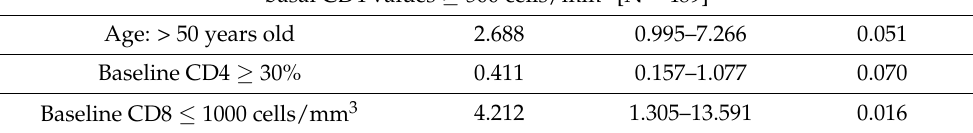
Table 2. Cont. Variable OR IC 95% p -Value Model 4. To achieve CD4/CD8 ≥ 0.9 at 24 weeks in PLWHIV to be treated DTG + 3TC and with basal CD4/CD8 < 0.9 [N = 272] NNRTI 2.119 0.906–4.955 0.083 Baseline CD4 ≥ 30% 0.336 0.111–1.019 0.054 Baseline CD8 ≤ 1000 cells/mm 3 0.326 0.129–0.823 0.018 Model 5. To achieve CD4 < 500 cells/mm 3 at 24 weeks in PLWHIV to be treated DTG + 3TC with basal CD4 values ≥ 500 cells/mm 3 [N = 489] Age: > 50 years old